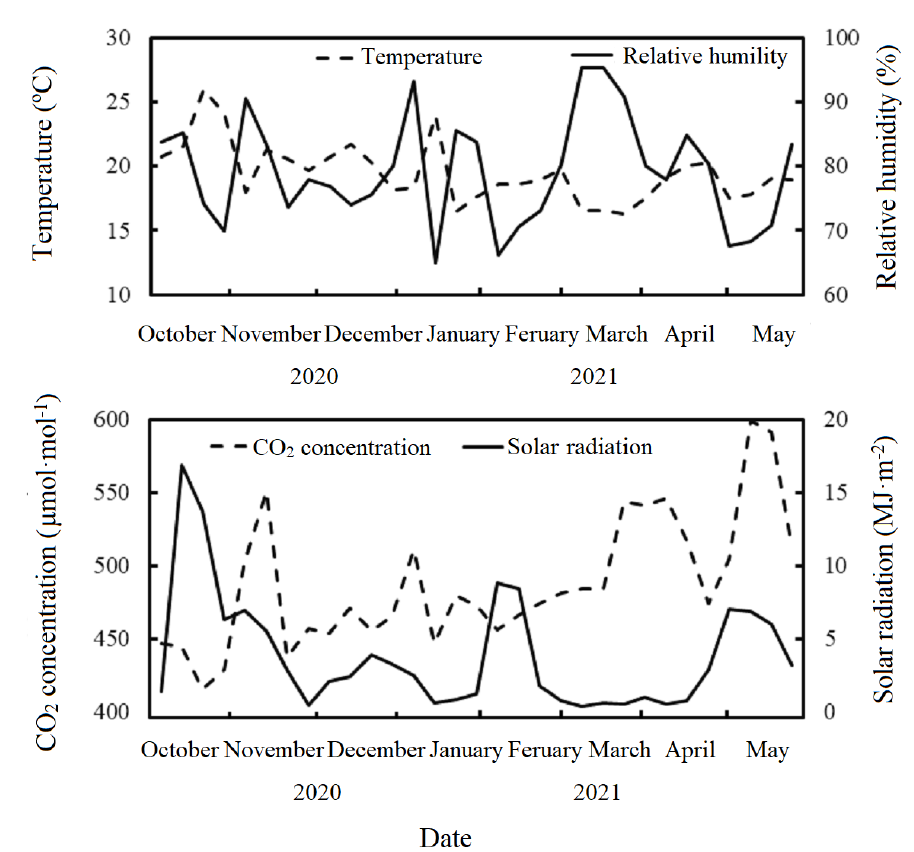
Figure 1. Variation in daily mean air temperature, relative humidity, CO 2 concentration, and integral amount of solar radiation inside the greenhouse from October 2020 to May 2021.